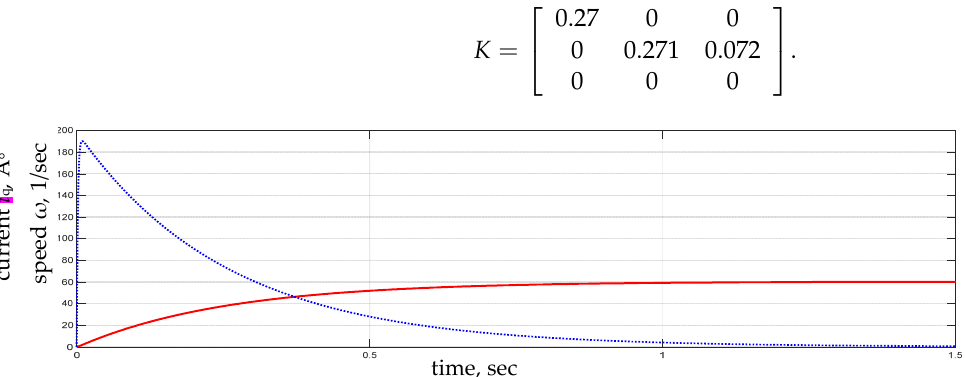
34 Figure 8. Experimental installation (1) computer control system; (2) SPMSM; (3) DC-machine load; (4) belt connection; (5) encoder. The parameters of the main SPMSM are the following: n н = 80 r/min, М н = 80 N·M, R s = 1,7143 Ohm, Ф = 0,1825 Wb, J m = 2.43 kg·m 2 , p p = 3 8, L d = 6,228 mH L q = 6,468 mH, b = 0,1. As such, the respective control matrix (19) will look like this: 0 27